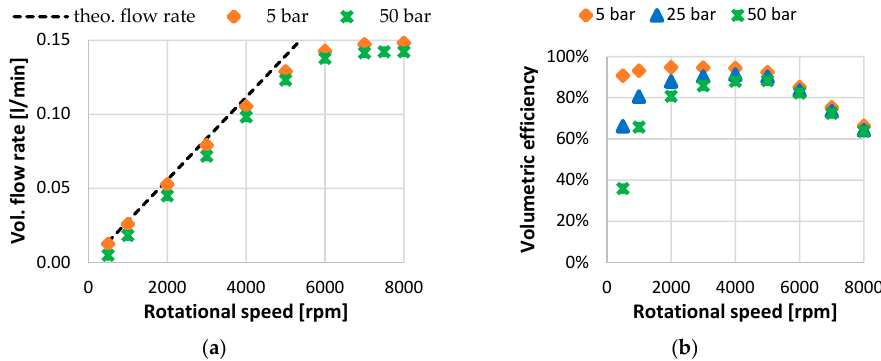
Figure 17. ( a ) Actual volumetric flow rate of the analyzed 2D pump and ( b ) volumetric efficiencies considering vapor cavitation at different delivery pressures and rotational speeds.